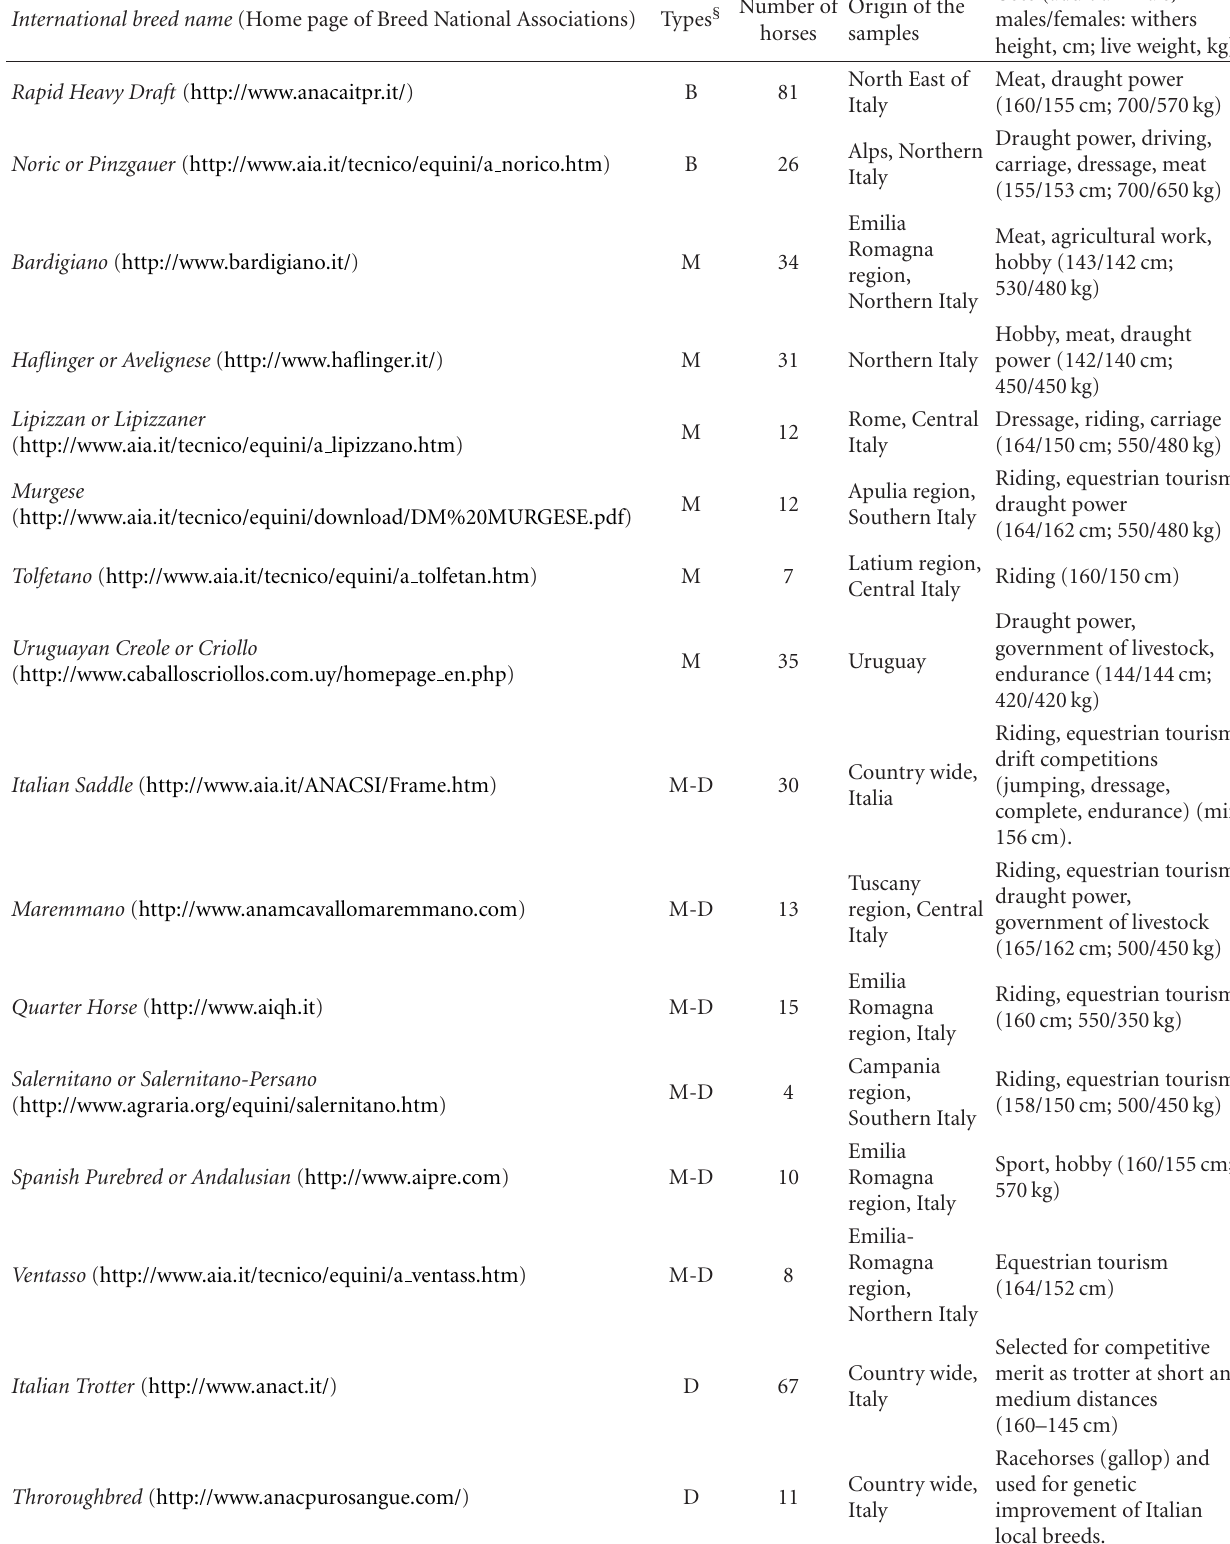
Table 1: Numbers, types, origin, uses, and morphological information of the analysed horse breeds ∗ . International breed name (Home page of Breed National Associations) Types §